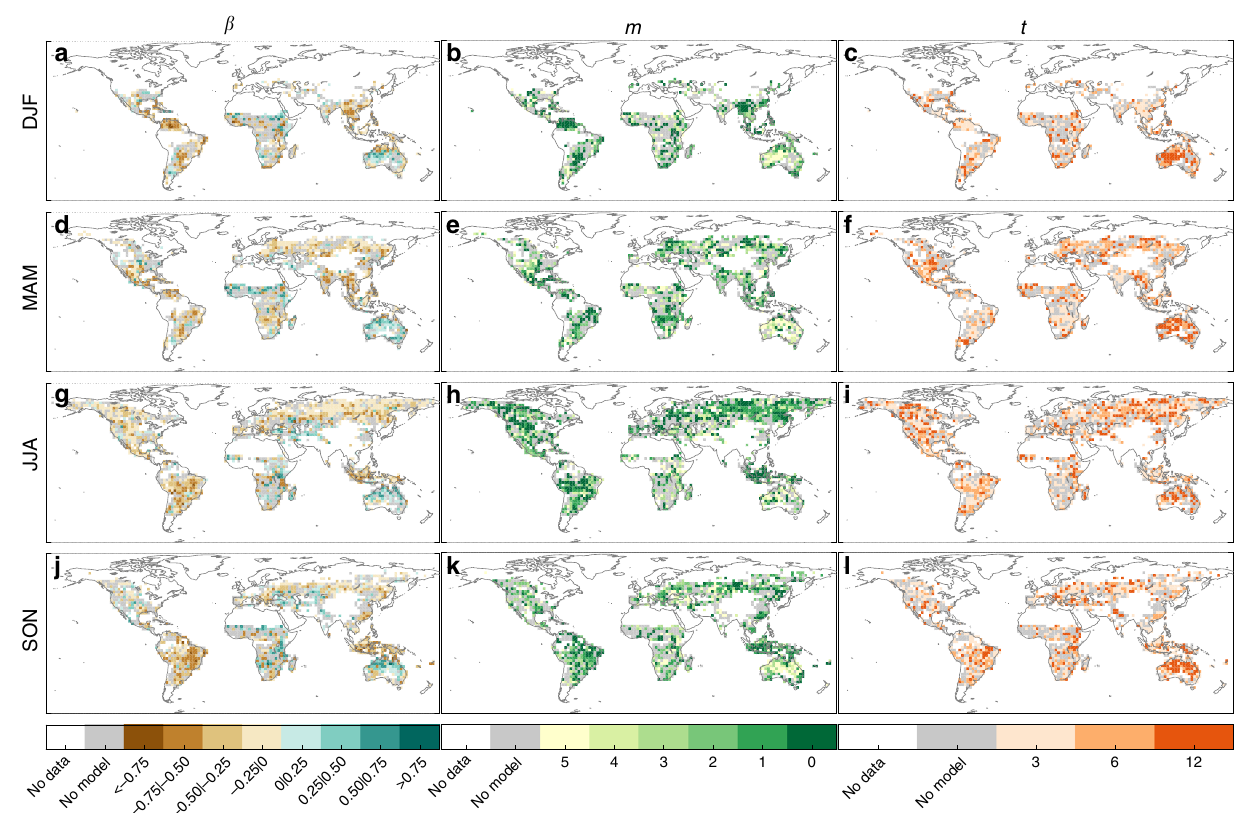
Fig. 8 Spatial distribution of the parameters involved in the burned area prediction model. Spatial distribution of the optimal values of coef fi cient β ( a , d , g , j ), of the lag ( m ) with reference to the last month M of the season considered ( b , e , h , k ) and of the accumulation time scale ( t : 3, 6 and 12 months; c , f , i , l ) of the burned area-SPI model de fi ned in Eq. (1) for the four seasons. Grey colour shadows the grid points with non-signi fi cant correlation values. White indicates areas where fi res do not occur (e.g. sea) or have not been